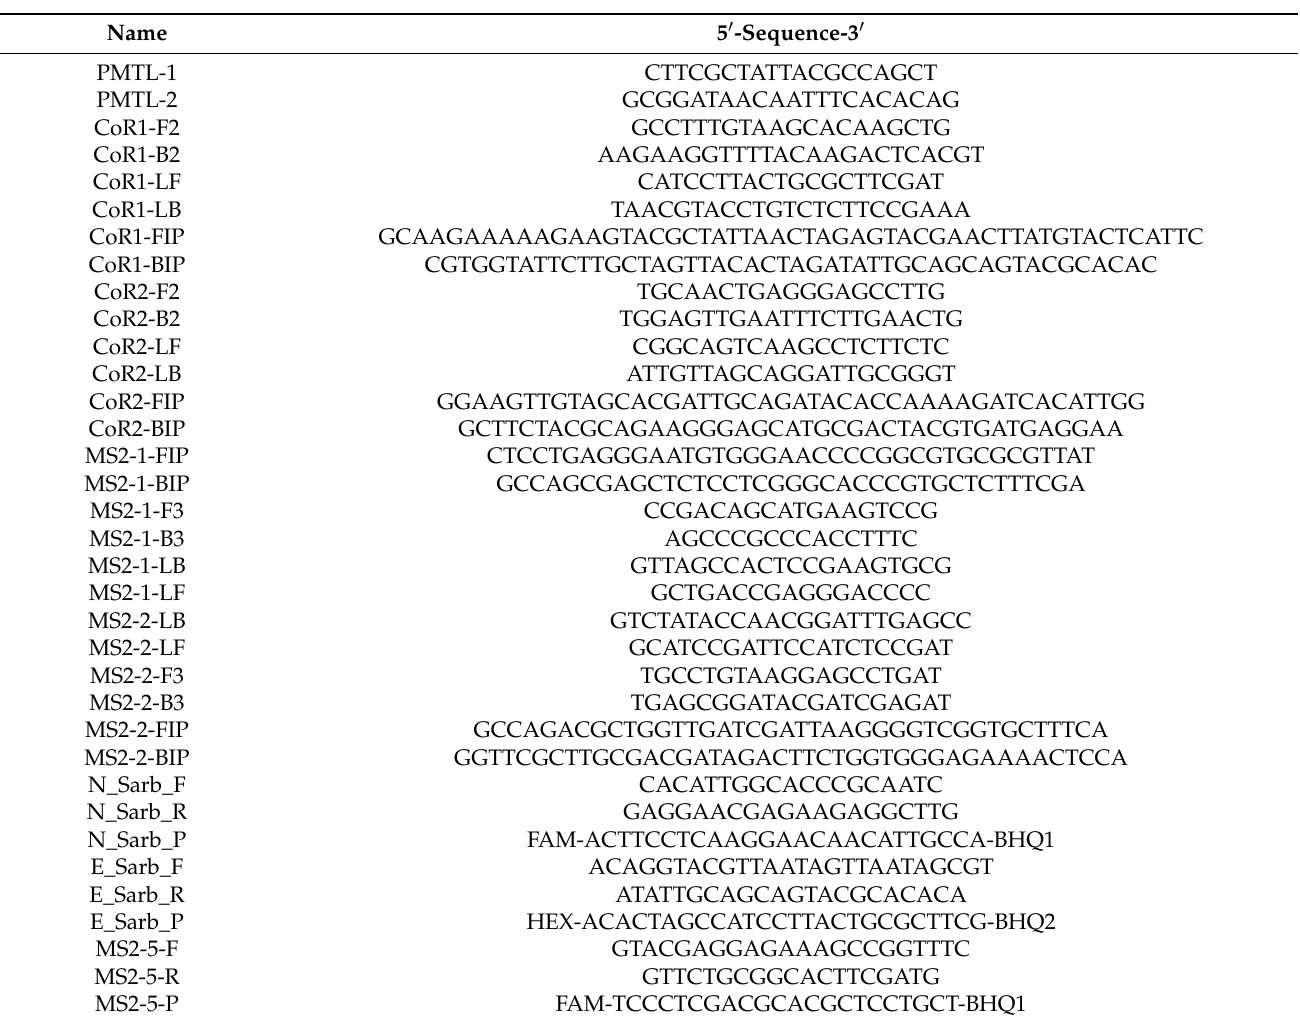
Table 1. List of oligonucleotide primers and